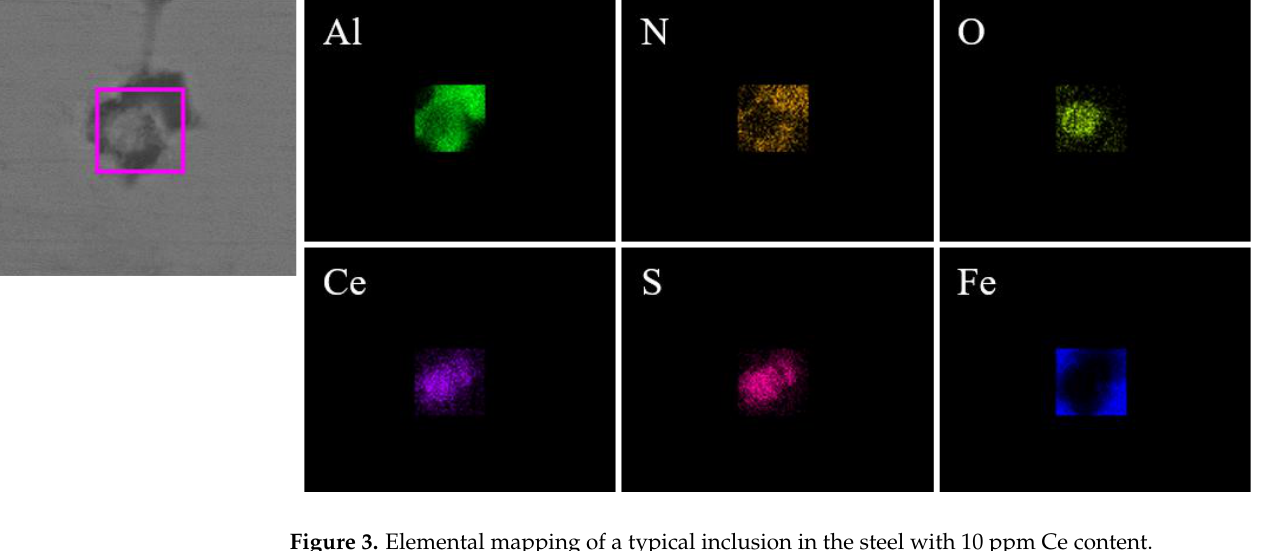
Figure 3. Elemental mapping of a typical inclusion in the steel with 10 ppm Ce content.